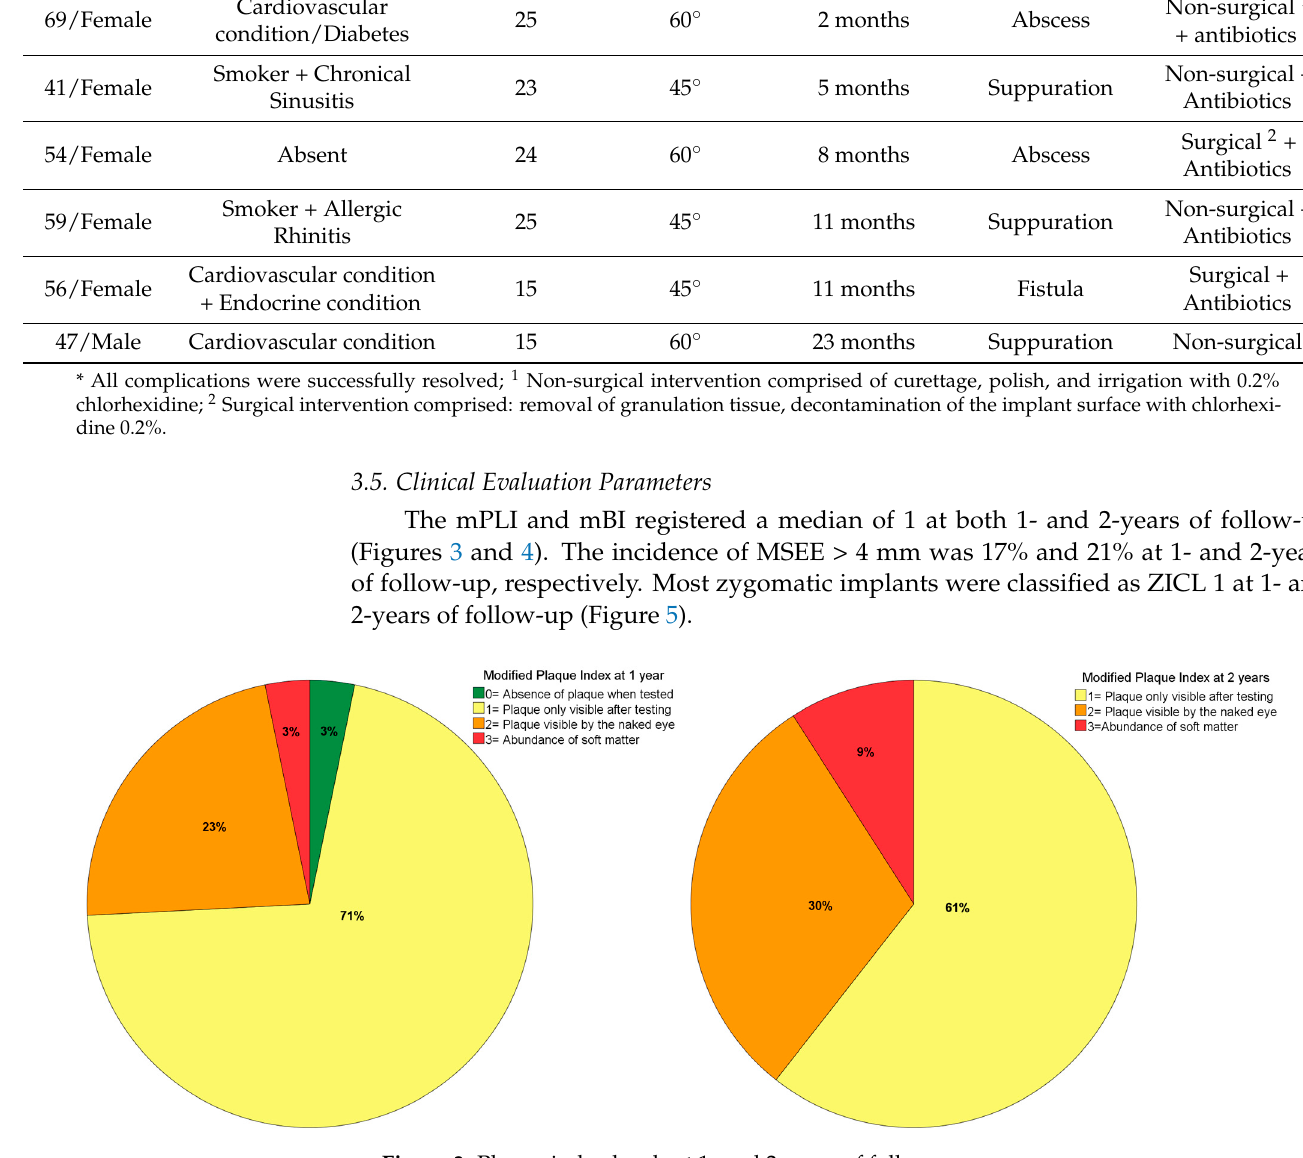
Figure 3. Plaque index levels at 1- and 2-years of follow-up.